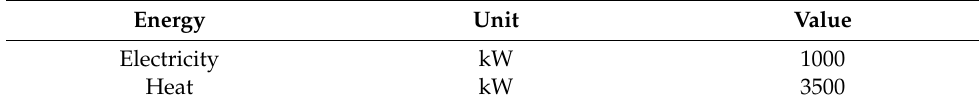
Figure 3. Electricity usage during shift ( a ) and heat demand during the year ( b ). Table 1. Nominal power of energy connection.